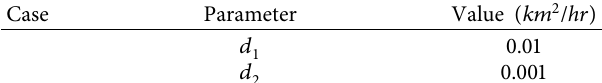
Table 1: Exposed and infected people from March 2020 to De-